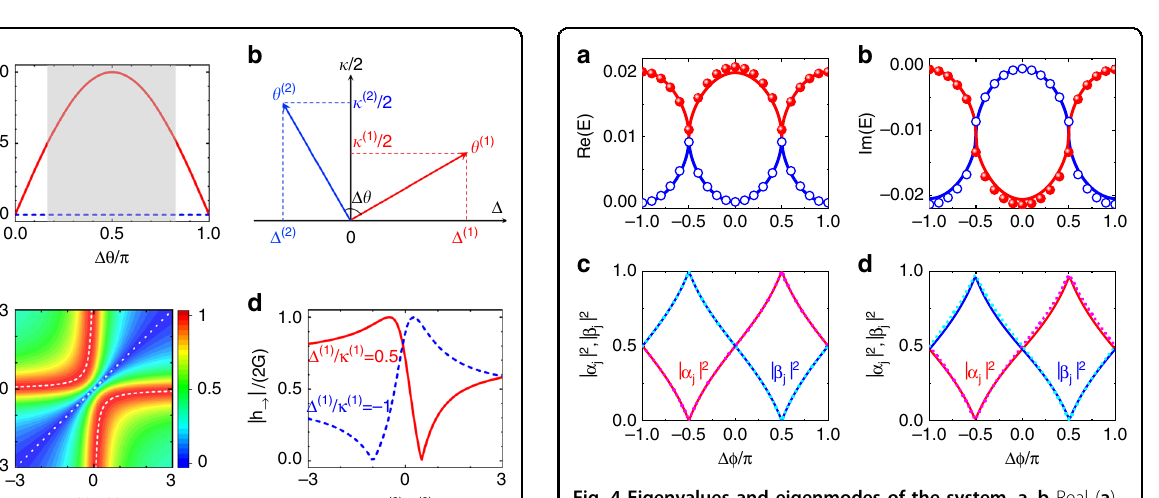
Fig. 4 Eigenvalues and eigenmodes of the system. a , b Real ( a ) and imaginary ( b ) parts of the eigenvalues for the effective Hamiltonian [Eq. (2), curves] and the original Hamiltonian [Eq. (1), dots] as functions of Δ ϕ . c , d Expansion coef fi cients of the eigenmodes for the effective Hamiltonian (2) ( c ) and the original Hamiltonian (1) ( d ) as functions of Δ ϕ . The red solid and magenta dotted curves illustrate the distribution in mode a m for each eigenmode ( j α 1 ; 2 j 2 ), and the blue solid and cyan dotted curves show the distribution in mode a m + 1 for j 2 ). The parameters are κ ð 1 Þ ¼ κ ð 2 Þ (cid:3) κ , each eigenmode ( j β 1 ; 2 ffiffiffiffiffiffiffiffiffiffiffiffiffiffiffiffiffiffiffiffiffiffiffiffiffiffiffi j Δ ð 2 Þ = κ þ i = 2 j